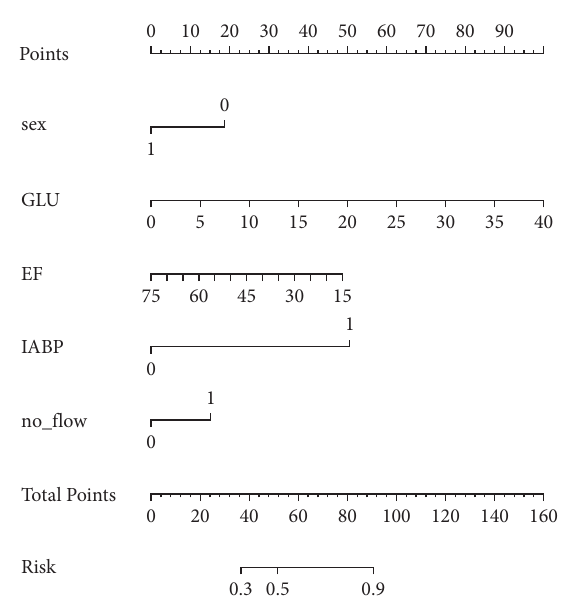
Figure 1: Nomogram for the prediction of in-hospital mortality in patients with acute ST-elevation myocardial infarction after pri- mary PCI. GLU indicates random blood glucose on admission; EF indicates ejection fraction after PCI; IABP indicates intra-aortic balloon